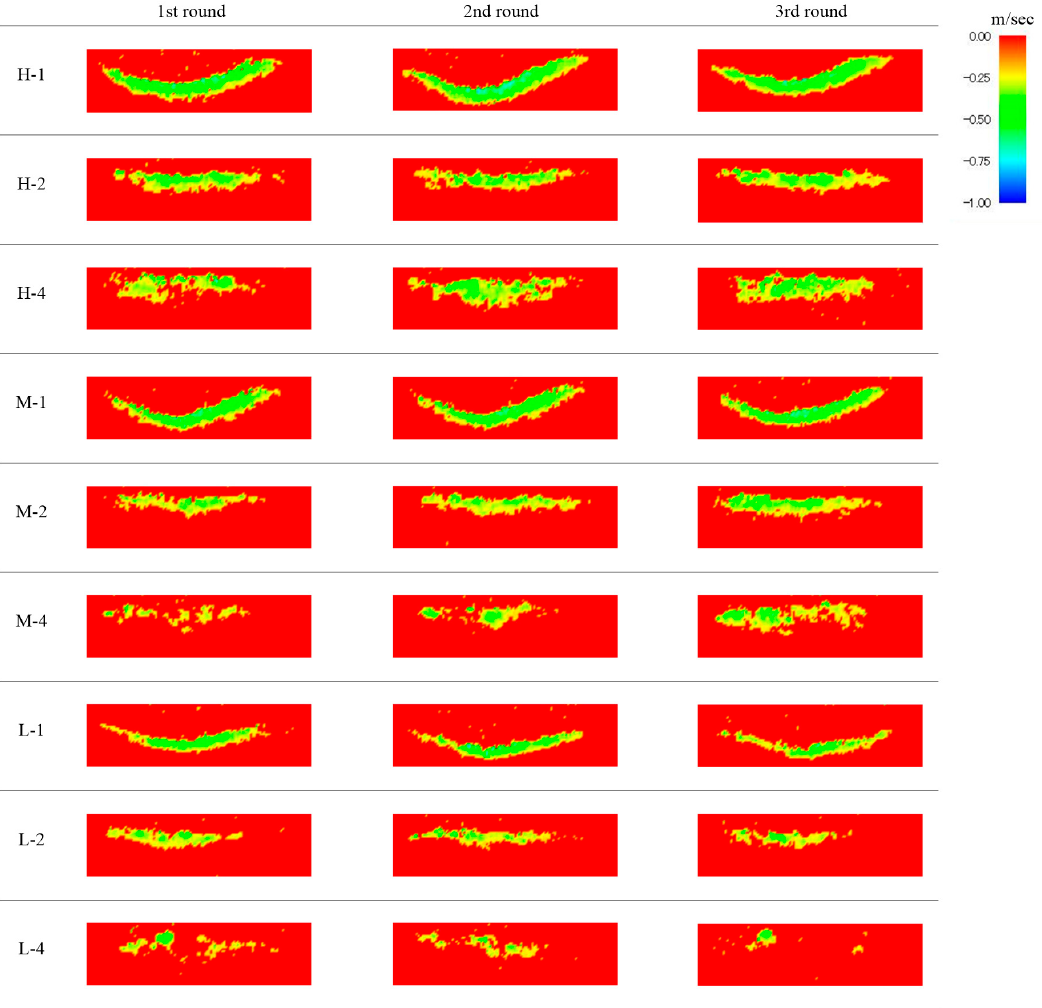
Figure 8. Flow velocity distributions from the results of M-1.